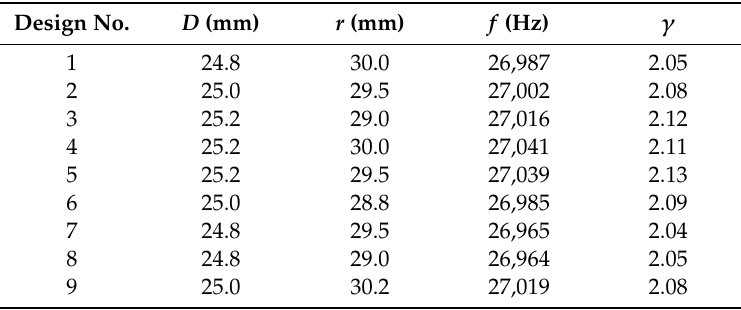
Table A2. CCD design table and the relevant FE analysis results (Type 2). Design No.